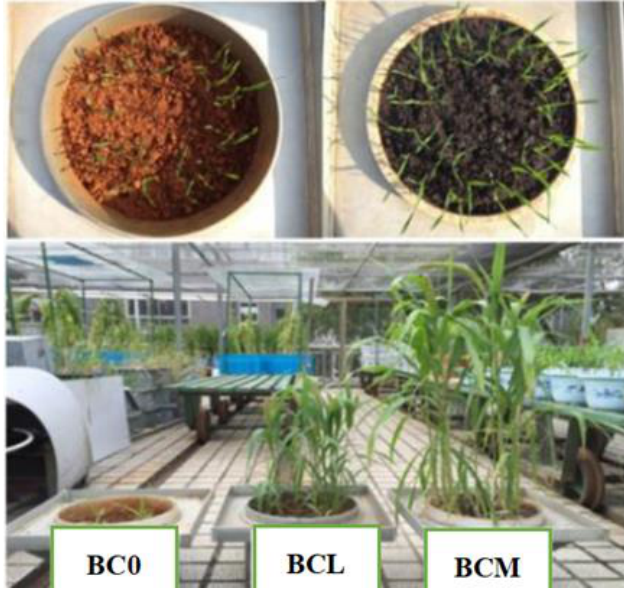
Figure 1. Plants growth status in pot